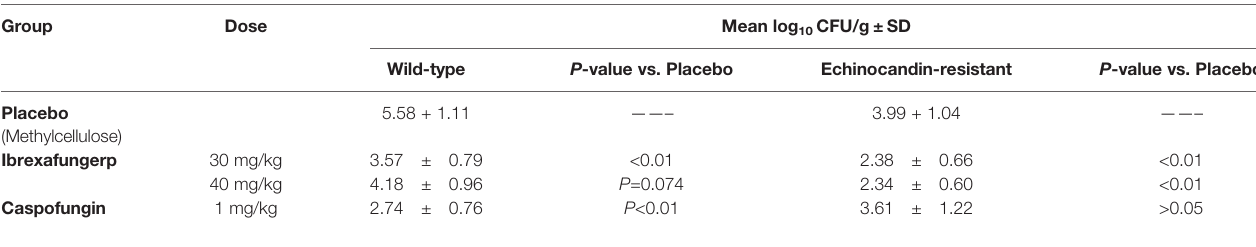
TABLE 5 | Assessment of the ef fi cacy of ibrexafungerp and a comparator against both wild-type and echinocandin-resistant C. glabrata infections in a neutropenic mouse model (Lockhart et al., 2012). Group Dose Mean log 10 CFU/g±SD Wild-type P -value vs. Placebo Echinocandin-resistant P -value vs. Placebo Placebo (Methylcellulose)